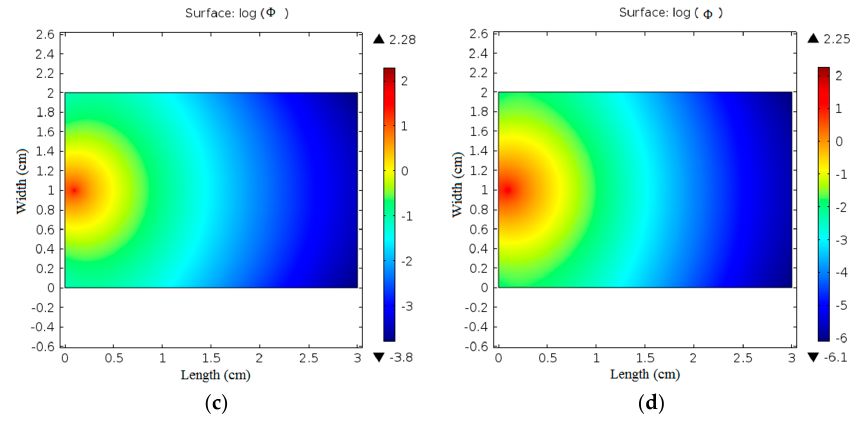
Figure 7. Fluence rate at tissue samples surface: ( a ) normal chicken skin at 635 nm; ( b ) boiled chicken skin at 635 nm; ( c ) normal chicken skin at 808 nm; ( d ) boiled chicken skin at 808 nm laser irradiation.